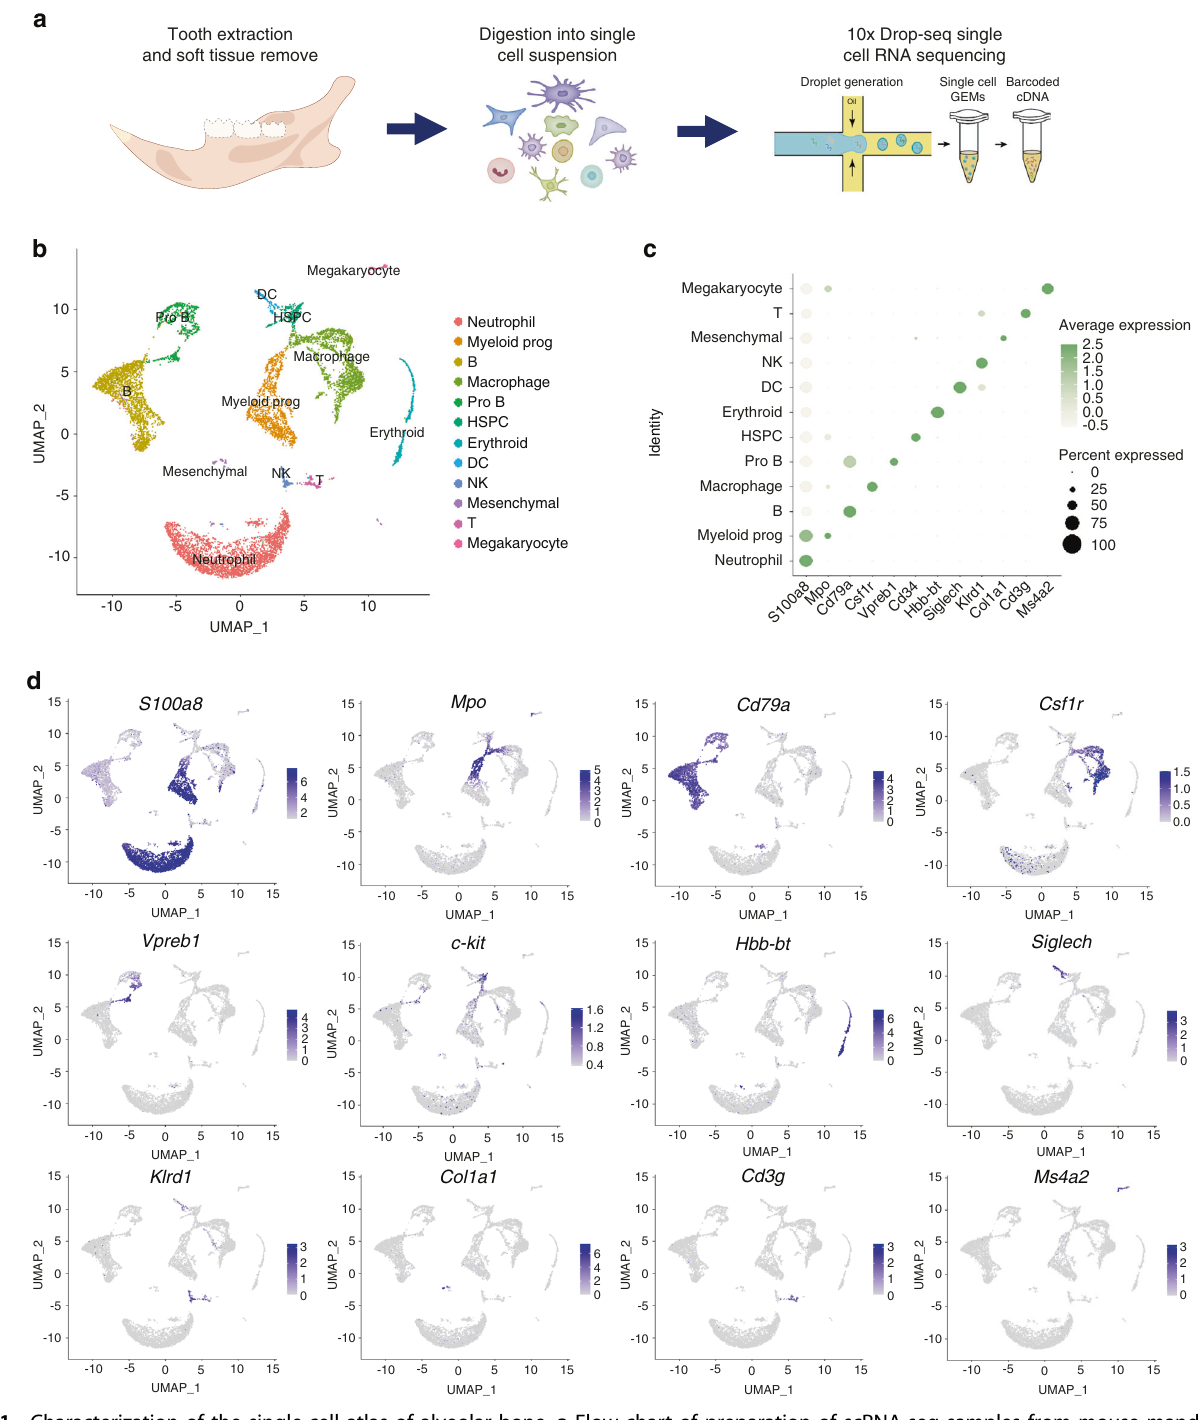
Fig. 1 Characterization of the single-cell atlas of alveolar bone. a Flow chart of preparation of scRNA-seq samples from mouse mandibular alveolar bone. b Cells identi fi ed by scRNA-seq were visualized with UMAP. Different cell populations were de fi ned and distinguished by color. Each point represented an independent cell. c Speci fi c expression of marker genes in different cell types. d The expression levels of marker genes were projected onto UMAP atlas (Fig. S1c). Then the UMAP method was applied to reduce the number of 10 224 cells were obtained with 29 053 genes of each cell. dimensionality (Fig. S1c). Cells were divided into 12 subgroups based We preprocessed the dataset with Seurat package. The median value on classic cell surface markers (neutrophil — S100a8 , myeloid progeni- of feature_RNA is between 1 000 and 2 000, and cells with tor — Mpo , macrophage — Csf1r , dendritic cell — Siglech , B cell — mitochondrial gene expression higher than 25% are fi ltered out Cd79a , pro-B cell — Vpreb1 , T cell — Cd3g , natural killer cell — Klrd1 , (Fig. S1a, b). After quality control, 2 000 genes with the most variable megakaryocyte — Ms4a2 , erythrocyte — Hbb-bt , hematopoietic stem value from 29 053 genes were selected for subsequent analysis Bone Research (2021)